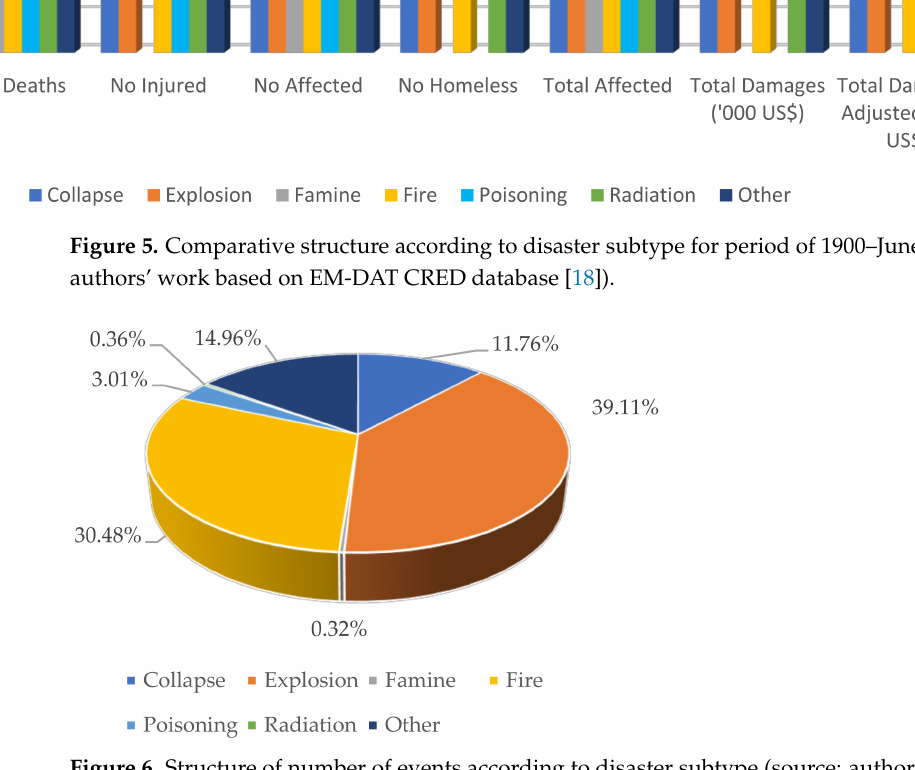
Figure 6. Structure of number of events according to disaster subtype (source: authors’ work based on EM-DAT CRED database [18]).